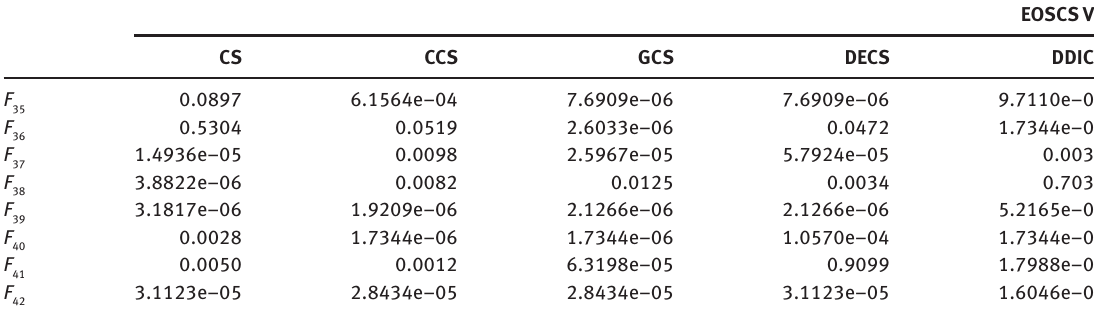
Table 14: p -Values Produced by Wilcoxon’s Test Comparing EOSCS versus CS, EOSCS versus CCS, EOSCS versus GCS, EOSCS versus DECS, and EOSCS versus DDICS Over The “Average Best-So-Far” Values from Table